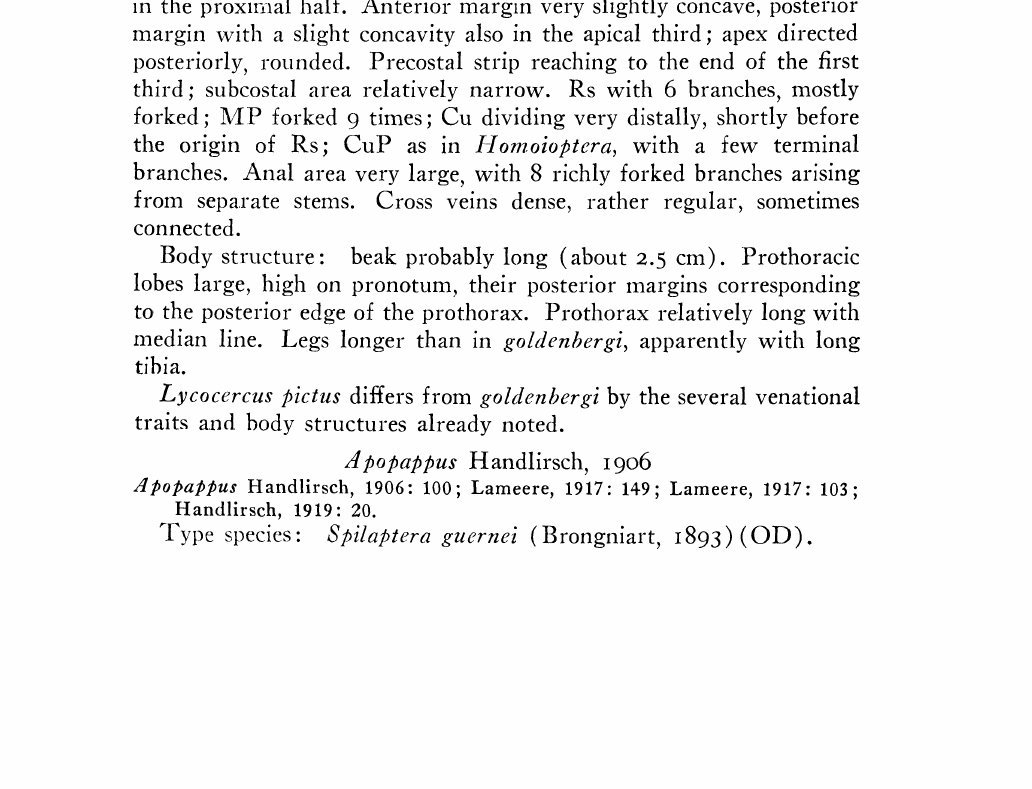
Figure 36. Lycocercus pictus Handlirsch; prothorax, basal part of fore wing, fragment of fore leg (1) and beak (b).